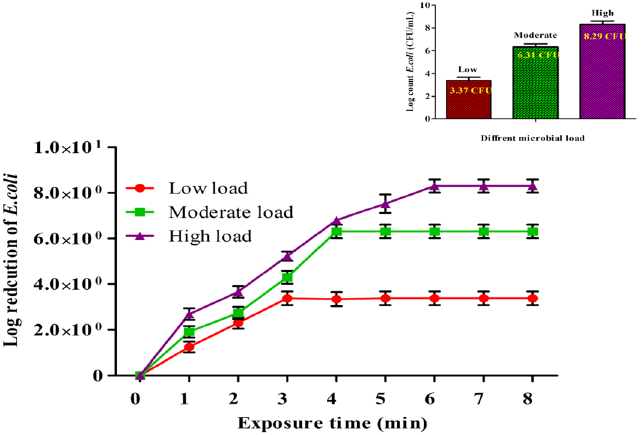
Figure 5. Effect of various bacterial populations on E. coli during electrochemical inactivation treatment. Experimental data are shown as mean ± standard deviation (n =